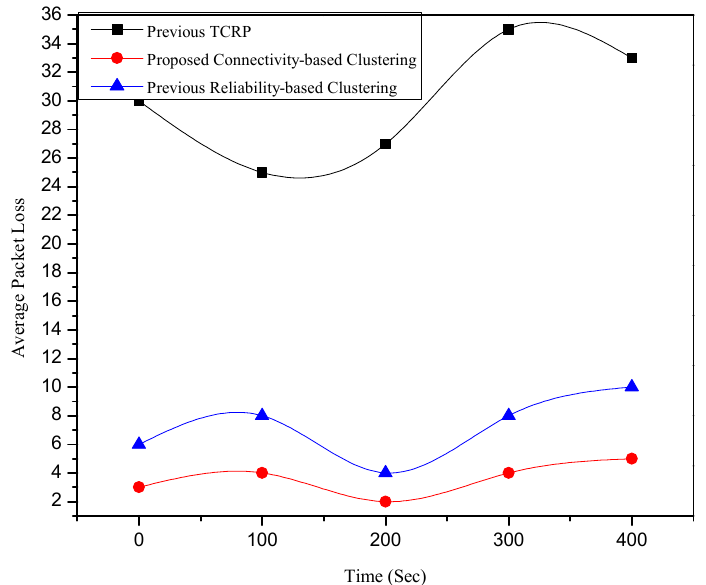
Figure 4. Comparison of our suggested connectivity-based clustering packet loss with the previous reliability-based clustering [3] and TCRP